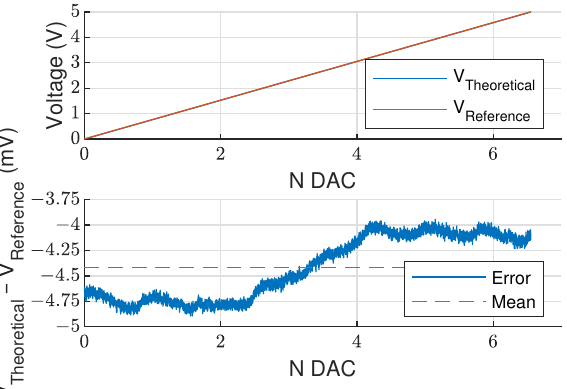
Figure 4. Characterization of the setting output voltage with no output current. Measured and expected values ( top ). Setting voltage error ( bottom